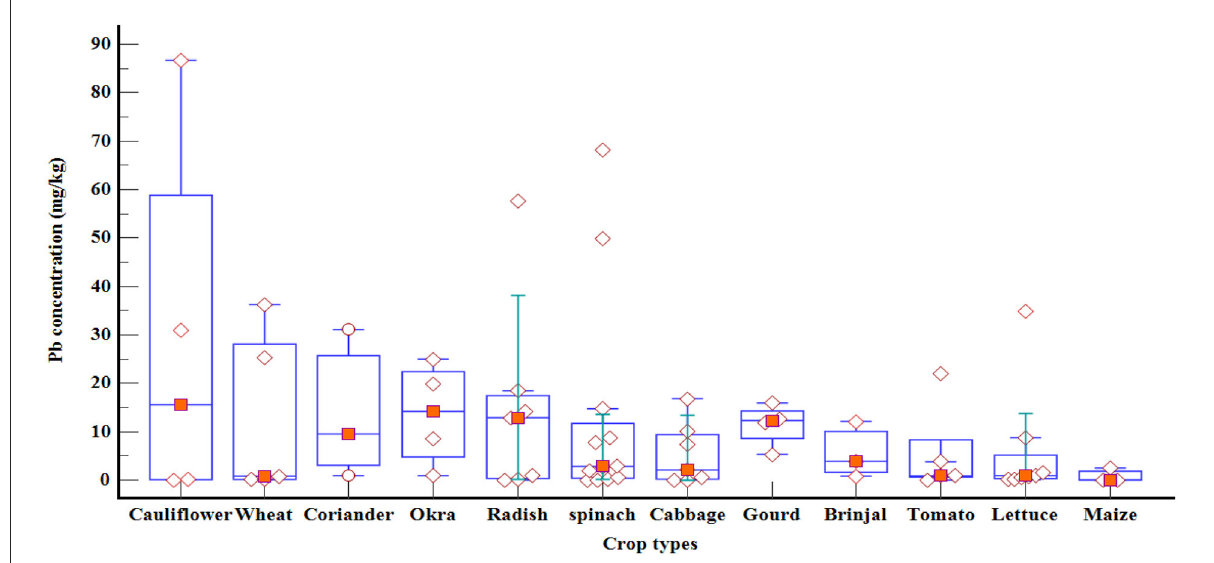
FIGURE8 Box and whisker plot of Pb concentration in twelve crops (studied three to twelve times by different authors). The diamonds represents individual